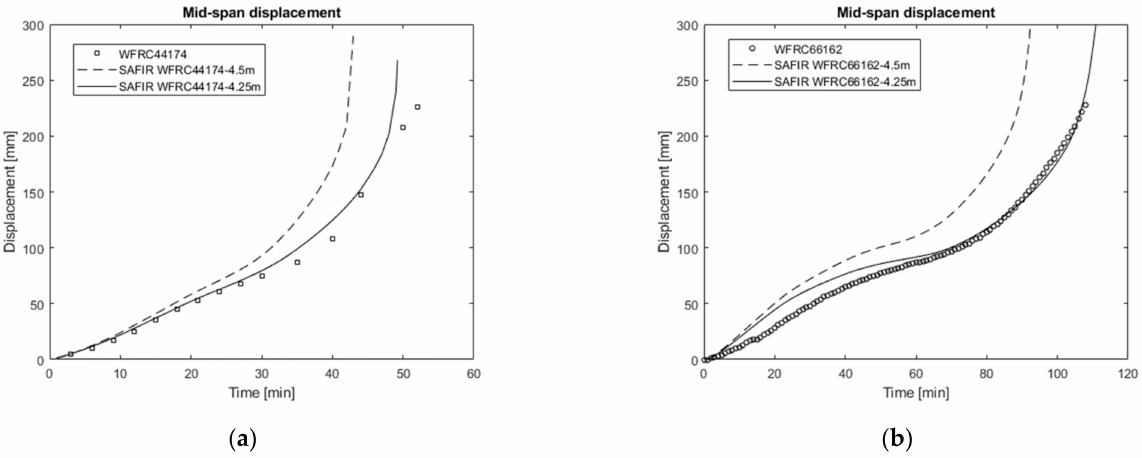
Figure 8. Vertical displacement at mid-span: comparison between numerical model and experiment: ( a ) WFRC 44174; ( b ) WFRC 66162